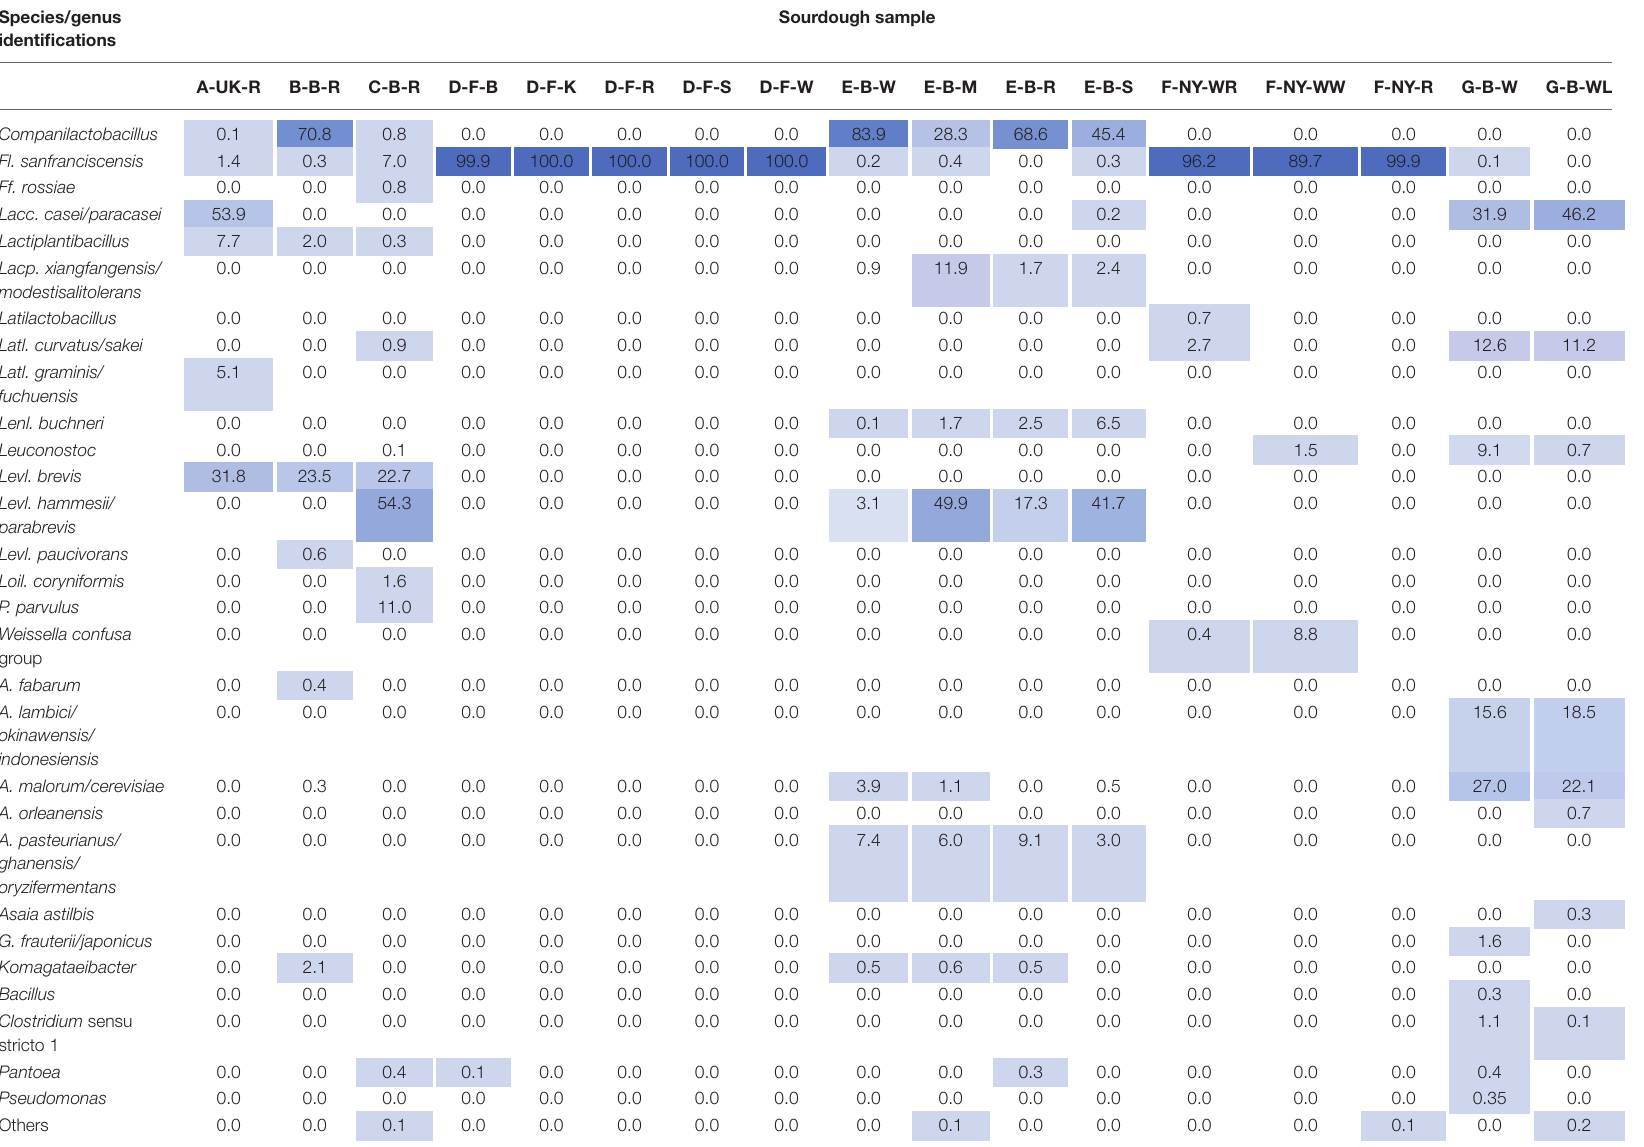
TABLE 3 | Relative abundance (%) of bacterial amplicon sequence variants (ASVs) obtained through metagenetic analysis of 17 sourdough samples from backslopped sourdoughs of different origins. Species/genus